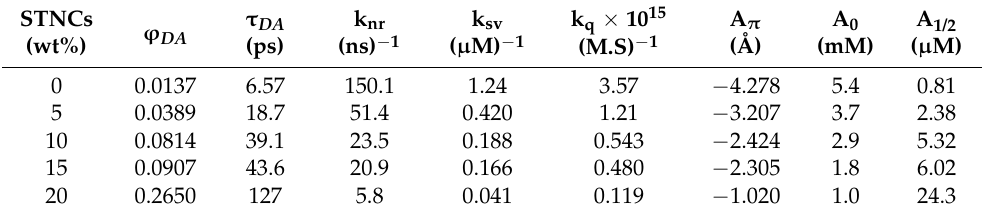
Table 1. Optical properties of PFO/10 wt% MEH-PPV hybrid thin film with various content of STNCs.